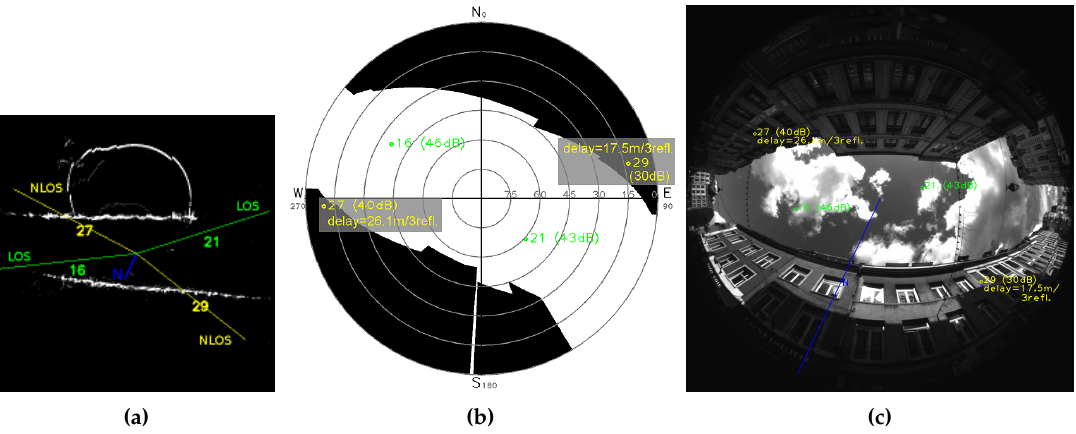
Figure 20. Instant 20 of acquisition Cap4/1560, pictures with satellites status given by the visibility mask method. The blue line indicates geographic North. LOS receptions are in green. NLOS receptions are in yellow with delay estimation. ( a ) Ground map with direct rays; ( b ) Skyplot and visibility mask; ( c ) Fisheye picture with